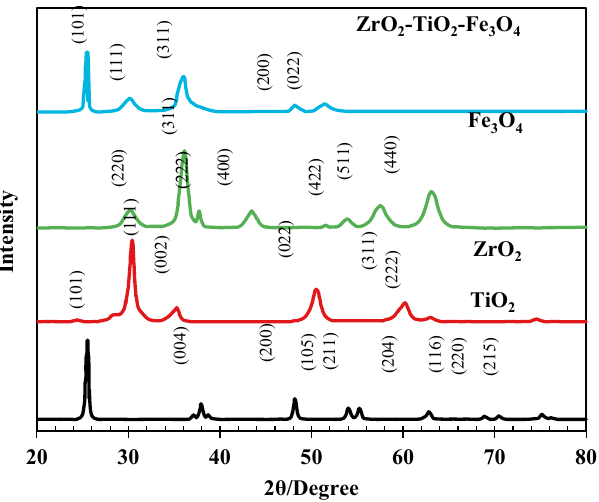
Figure 1. The XRD patterns of ZrO 2 , TiO 2 , Fe 3 O 4 , and ZrO 2 /TiO 2 /Fe 3 O 4